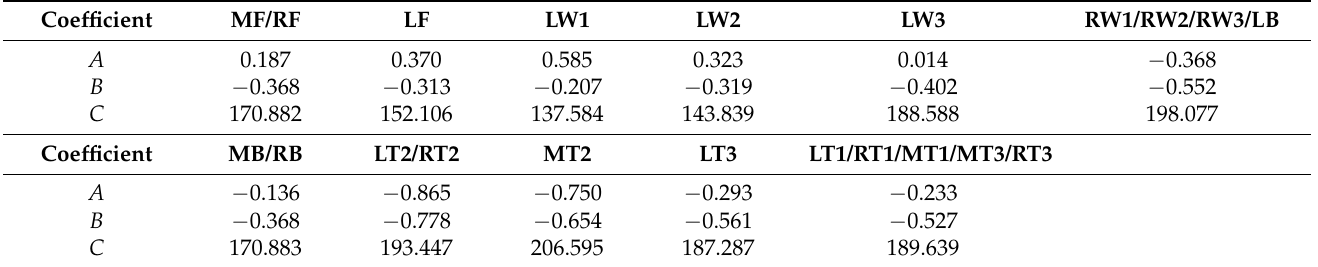
Table 8. The values of the fitting coefficients when the azimuth angle of the shed is 45 ◦ .